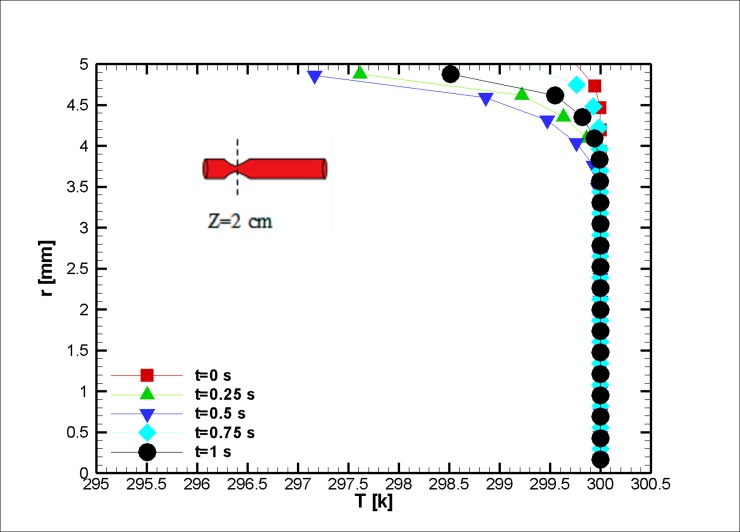
Profile of the temperature distribution at the stenosis at z = 2 cm for the case without Joule heating at five different time instances, Lvessel = 7 cm, Rvessel = 1 cm and fifty percent stenosis.